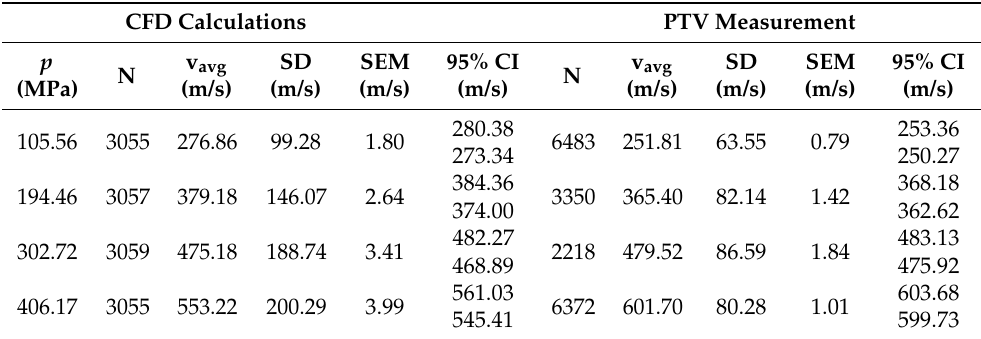
Table 4. Comparison of the average values of abrasive particle velocities from CFD calculations and PTV measurement for an abrasive mass flow rate of 300 g/min.